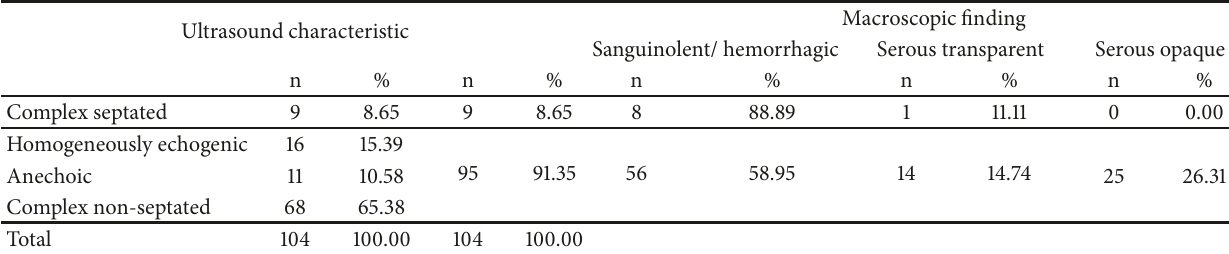
Table 2: Ultrasound features and macroscopic appearance of malignant pleural effusions. Macroscopic finding Ultrasound characteristic Sanguinolent/ hemorrhagic Serous transparent Serous